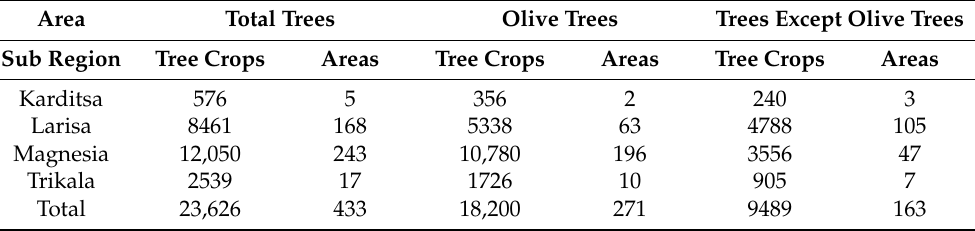
Table 6. Agricultural holdings in the region of Thessaly (land in thousands of acres) [61]. Area Total Trees Olive Trees Trees Except Olive Trees Sub Region Tree Crops Areas Tree Crops Areas Tree Crops Areas